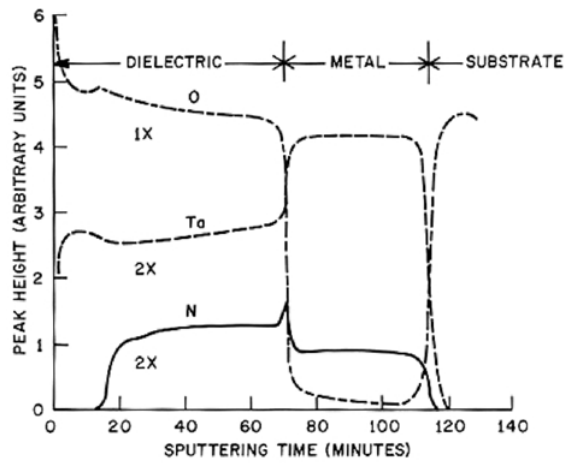
FIGURE 3 Peak height of Ta, O, and N Auger signals as a function of sputtering time to illustrate distribution of these elements in anodic films formed to 150V on Ta-13 atomic % N alloy